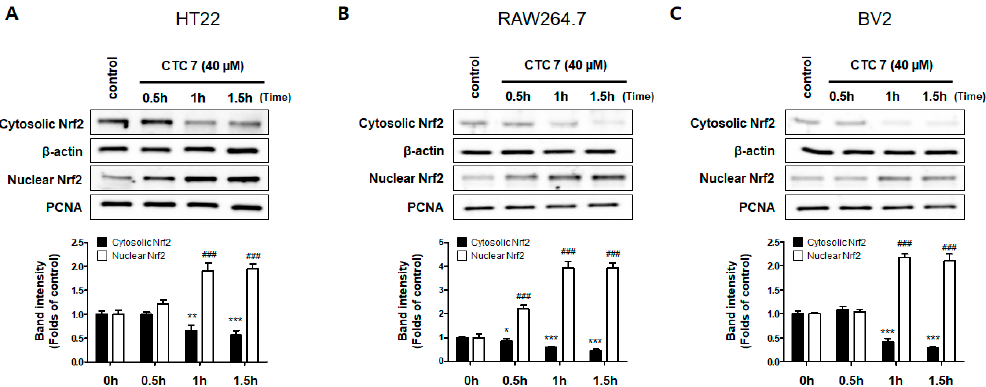
Figure 5. Effects of CTC 7 treatment on the nuclear translocation of nuclear factor erythroid-derived 2-related factor-2 (Nrf2) in HT22 ( A ), RAW264.7 ( B ), and BV2 ( C ) cells. These cells were treated with CTC 7 (40 μ M) for 0.5, 1, or 1.5 h and then the nuclei were fractionated from the cytosol using a Caiman Nuclear Extraction Kit. Cytoplasmic and nuclear Nrf2 expression was then assayed using western blotting. Data represent the mean ± standard deviation for three independent experiments. * p < 0.05, ** p < 0.01 *** p < 0.001 when compared to the untreated cytosolic Nrf2 control. ### p < 0.001 when compared to the untreated nuclear Nrf2 control.